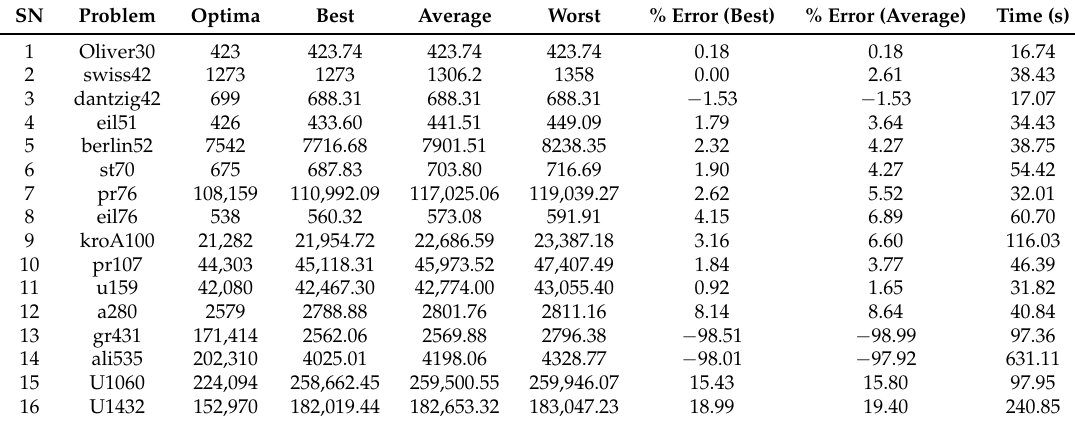
Table 9. Simulation results of the BCSO algorithm instances of the Traveling Salesman Problem (TSP) from TSP library.